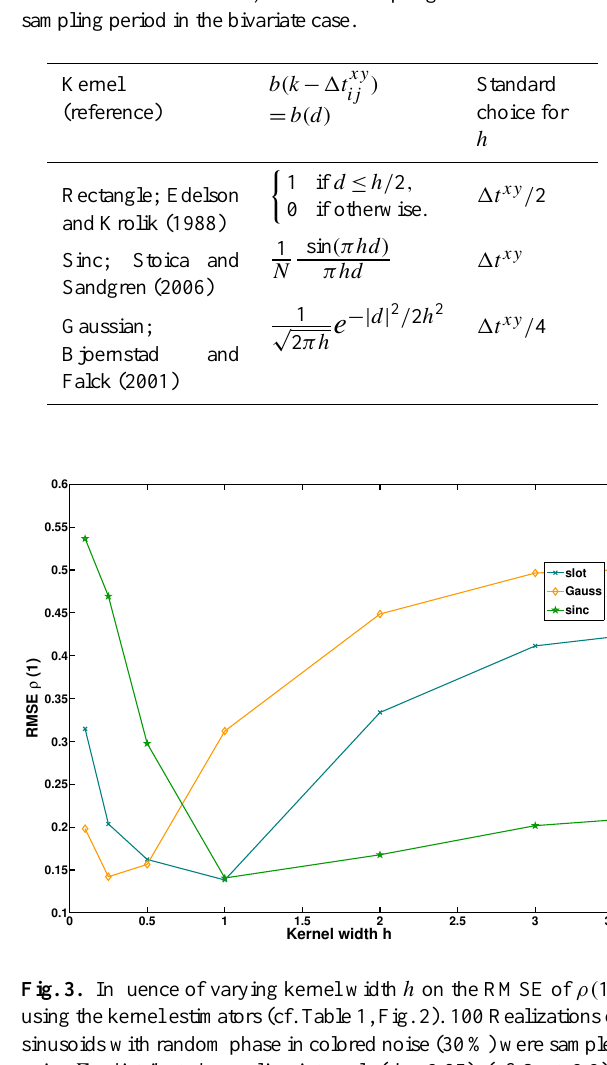
Table 1. Kernels b(d) used in this paper. d denotes the distance between the inter-observation time 1t xy and k1τ , k denotes the ij k -th lag. The standard width parameter h is chosen to result in a main lobe width of 1t xy , the mean sampling interval or common sampling period in the bivariate case.